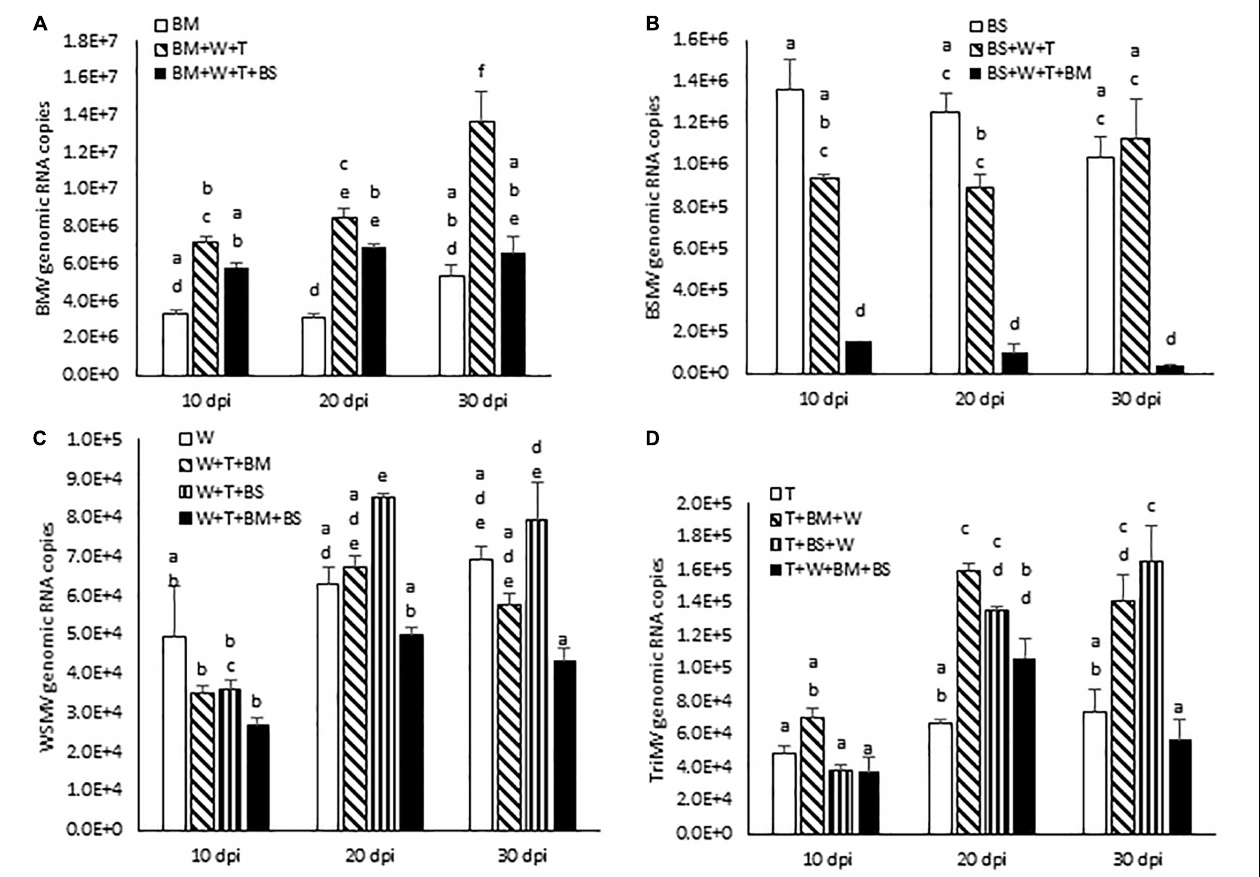
FIGURE 5 | Effect of co-infection of wheat by three (WSMV, TriMV, and BMV or BSMV) or four viruses (WSMV, TriMV, BMV, and BSMV) on genomic RNA accumulation of interacting viruses at 10, 20, and 30 dpi. Absolute quantification of genomic RNA copies of BMV (A) , BSMV (B) , WSMV (C) , and TriMV (D) were determined by real-time RT-PCR. Histograms indicate accumulation of viral genomic RNA copies in 2.5 ng total RNA with standard error. The same letters above the histograms indicate non-significant, whereas different letters indicate significance at p = 0.05. BM, BMV; BS, BSMV; W, WSMV; T,